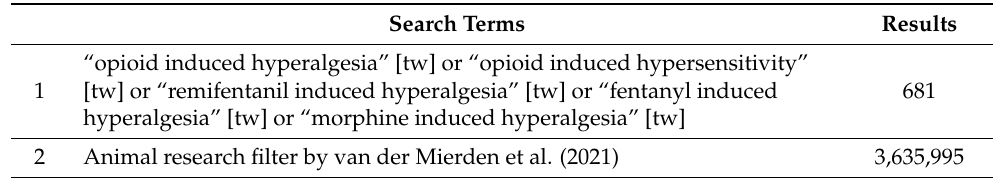
Table A6. Final PubMed search. The number of records retrieved for the disease of interest (1), animal research (2), interventions (3), and their combinations (4).